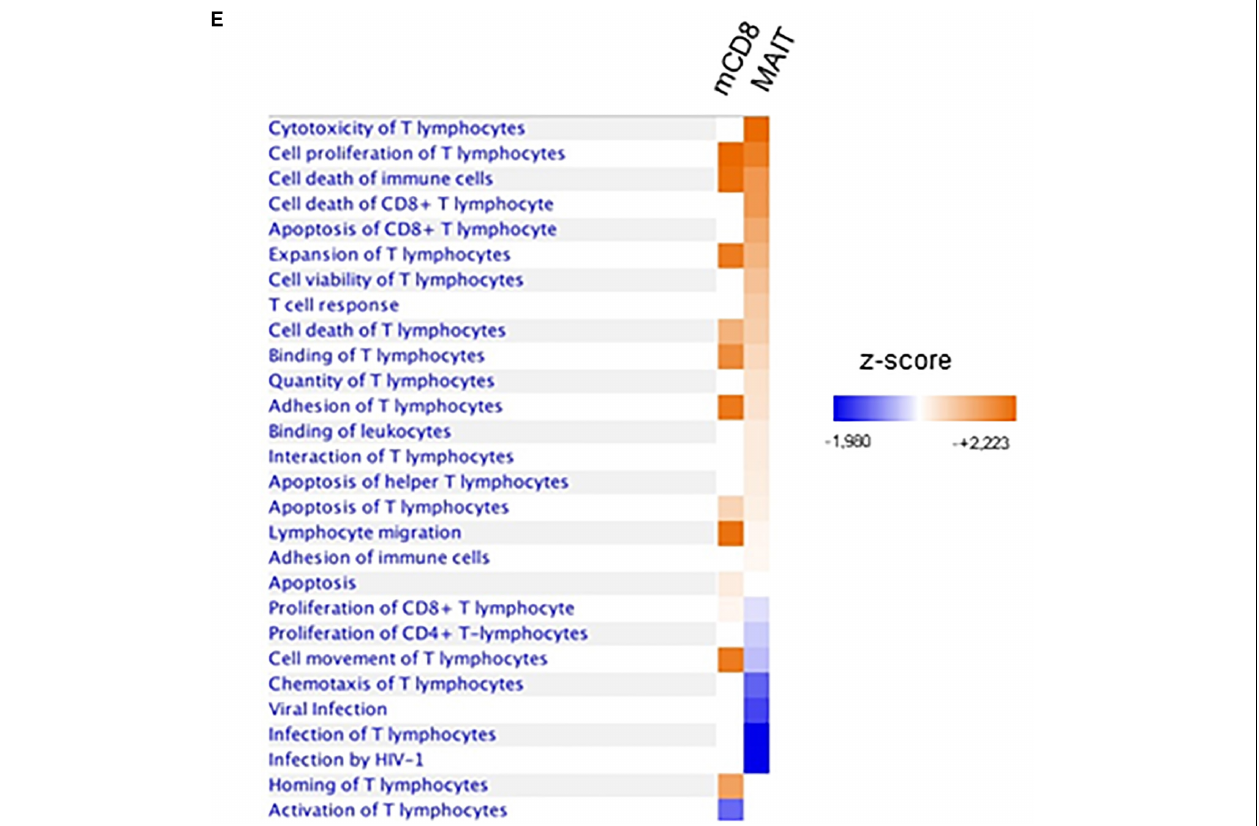
FIGURE 6 | IFN α 2b induces a specific set of genes in MAIT cells. (A) Principal component analysis of gene expression by untreated MAIT cells (blue), IFN α -stimulated MAIT cells (red), conventional memory CD8 + CD161 − T cells (purple), and IFN α -stimulated conventional memory CD8 + CD161 − T cells (green). Analysis was performed with the Transcriptome Analysis Console (TAC, version 4.0) software. (B) Volcano plot of differentially expressed genes (DEG) between MAIT and conventional memory CD8 T cells. Colored dots represent genes with at least a 2-fold difference. The main MAIT-associated genes are labeled. (C) Venn diagrams of the number of DEG induced by IFN α 2b stimulation in conventional CD8 memory and MAIT cells. (D) Pathway analysis of the genes differentially expressed in IFN α 2b-stimulated versus unstimulated MAIT cells. The left axis represents the % of genes within each pathway, and the right axis shows the –log ( p -value). Red bars represent upregulated, and green bars downregulated genes. Orange dots and line show the –log ( p -value) for each pathway. (E) Comparison of the main pathways regulated by IFN α 2b stimulation in conventional memory CD8 versus MAIT cells. Four different donors were analyzed in these experiments. Pathway analyses were performed with the Ingenuity Pathway Analysis